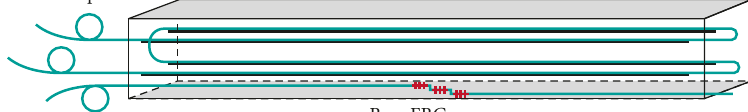
Figure 4: The sensor positions.